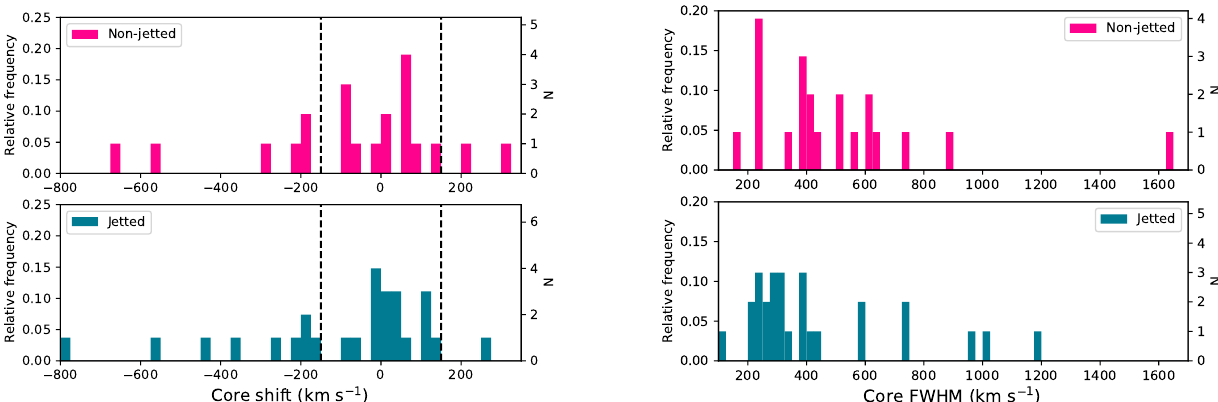
Figure 9. Left: distributions of the [O III] core velocity shift in km s − 1 , in steep-spectrum (top panel) and flat-spectrum jetted sources (bottom panel). The vertical dashed line indicate the limit for red or blue outliers at 150 km s − 1 . Binning of 25 km s − 1 . Right: distributions of the FWHM([O III]) wing component in km s − 1 in the same samples. Binning of 25 km s − 1 . Table 8. Results of the statistical tests for the spectral index samples. Columns: (1) Tested sample; (2) median velocity; (3) standard deviation of the velocity; (4) interquartile range; (5) p -value of the K-S tests against the other sample, observed in top row, simulated in middle row, and standard deviation of the simulated p -value in bottom row; (6) p -value of the A-D tests against the other sample, observed in top row, simulated in middle row, and standard deviation of the simulated p -value in bottom